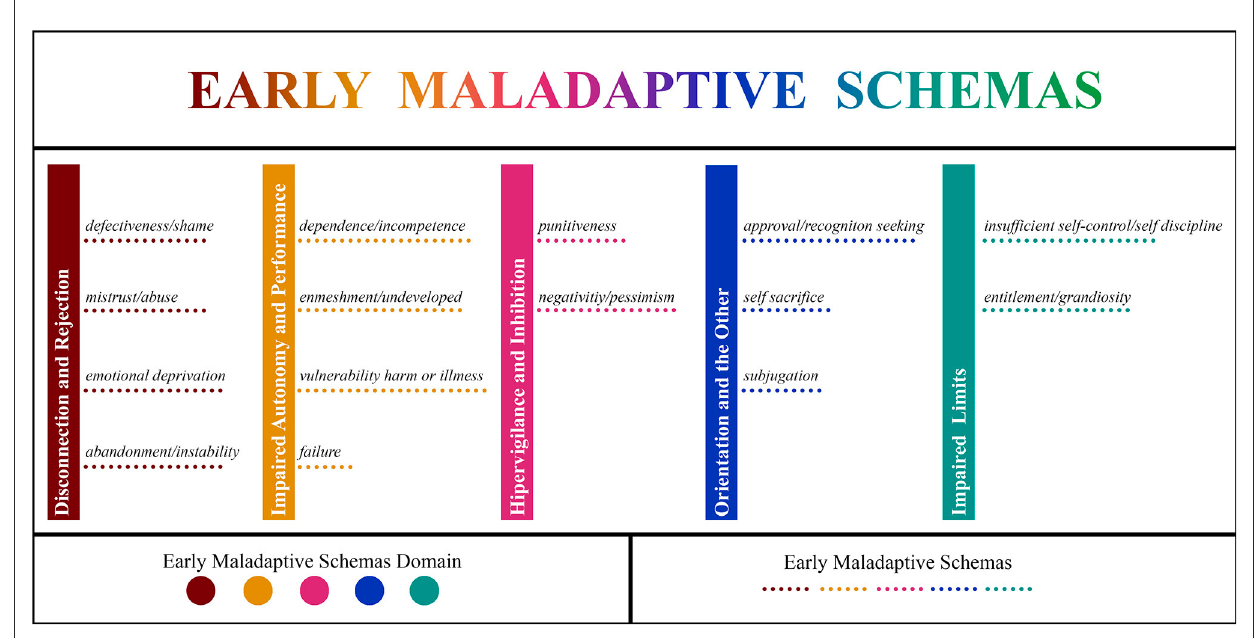
FIGURE1 Illustration of 15 early maladaptive schemas and five schema domains consisting of disconnection and rejection, impaired autonomy and performance, hypervigilance and inhibition, impaired limits, and orientation to the